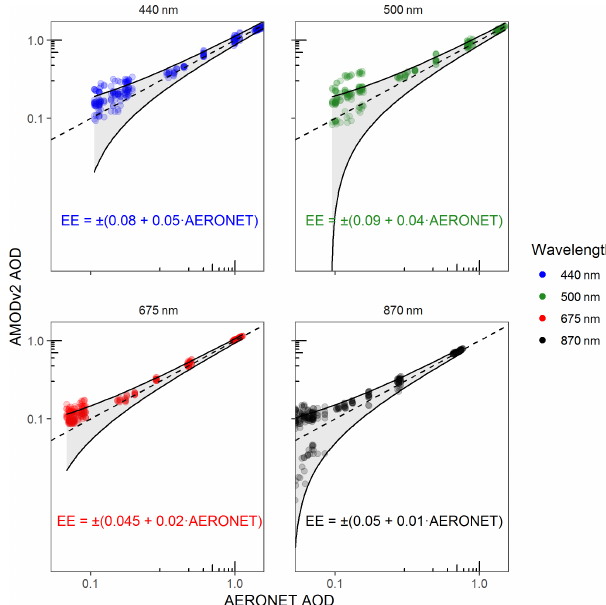
Figure 4. Logarithmic AERONET vs. AMODv2 AOD co-located results with expected error (EE; AOD units) bounds, with panels separated by wavelength. Equation bounds contain 85% of the co- located measurements.